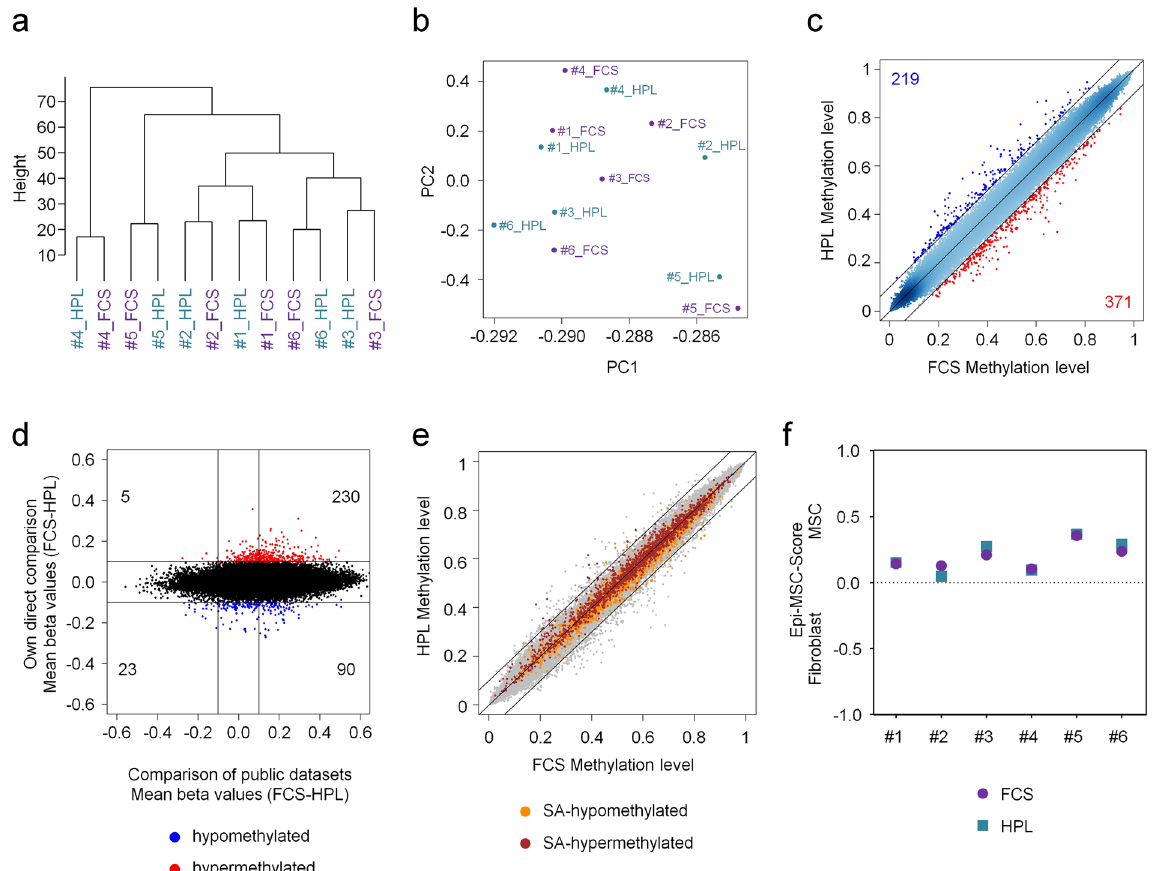
Figure 2. DNA-methylation patterns of MSCs are similar in HPL and FCS. ( a ) Hierarchical clustering of DNAm profiles (450 k BeadChips) discerned the six different MSC donors (n = 6). ( b ) Principal component (PC) analysis did not discern HPL-MSCs and FCS-MSCs. PC1 and PC2 are exemplarily depicted. ( c ) Scatter plot analysis of mean DNAm levels. CpGs that were at least 10% higher methylated in FCS or HPL are indicated in red and blue, respectively (none of the CpGs reached statistical significance). ( d ) Comparison of mean DNAm differences (FCS-MSCs/HPL-MSCs) in our study (y-axis) and publically available datasets (x-axis; 6 different studies, Supplementary Table S1). ( e ) This scatter plot depicts CpGs that either reveal senescence- associated hypermethylation (1,702 CpGs; red) or senescence-associated hypomethylation (2,116 CpGs; orange) during culture expansion of MSCs 15 . ( f ) Classification of cell preparations with the Epi-MSC-Score 12 confirmed that all cell preparations are